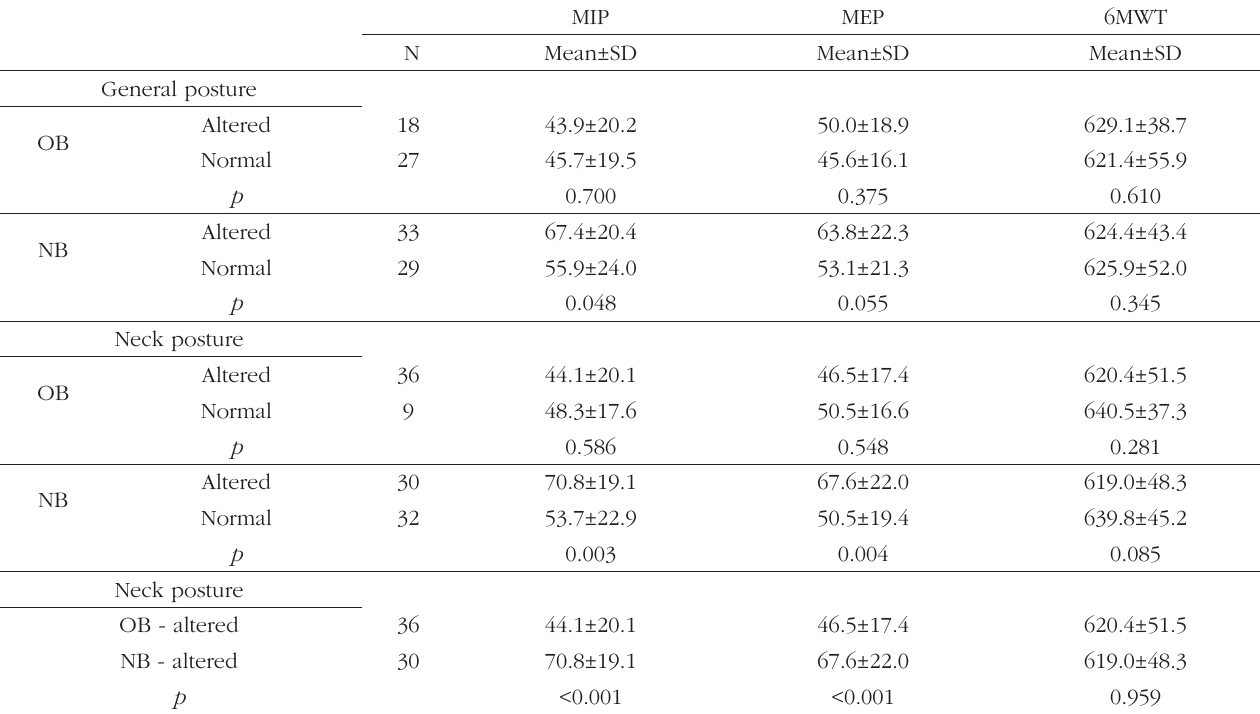
Table 4. Distribution of mean MIP, MEP, and 6MWT results in relation to general and neck posture in OB and NB groups.